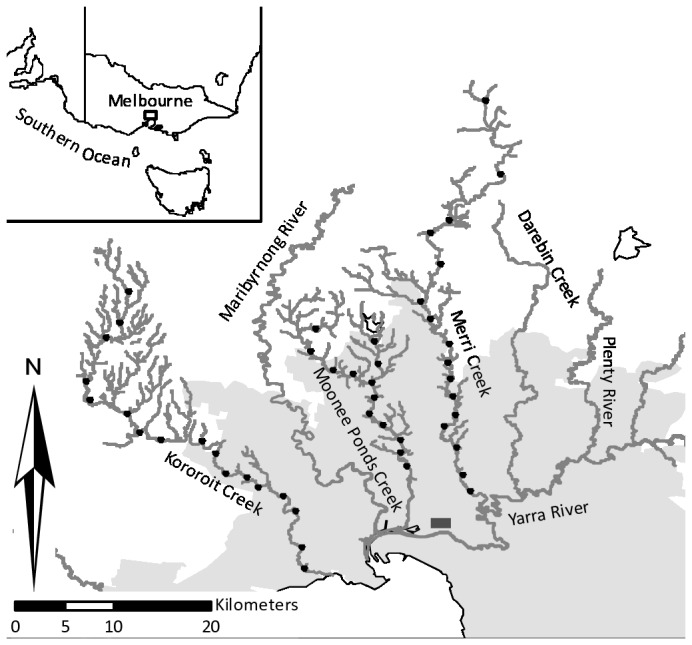
Map of the study area.Circles indicate the location of survey transects. The grey area represents the extent of current development, with the dark grey rectangle indicating the central business district of the city. Waterways in black.